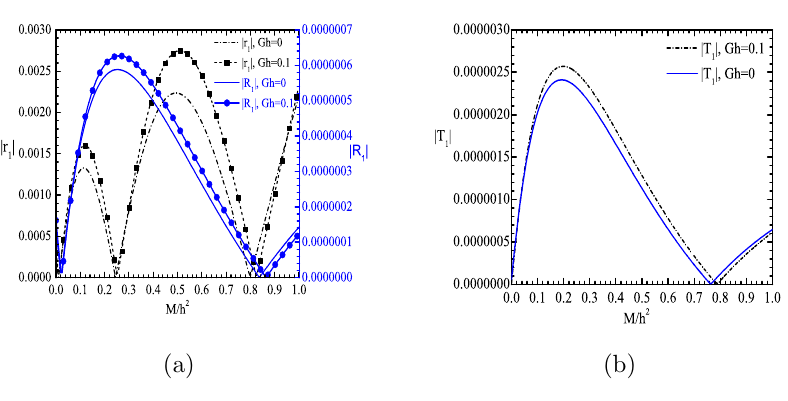
(cid:12) (cid:12) (cid:12) (cid:12) (cid:12) (cid:98) R 1 (cid:12) for